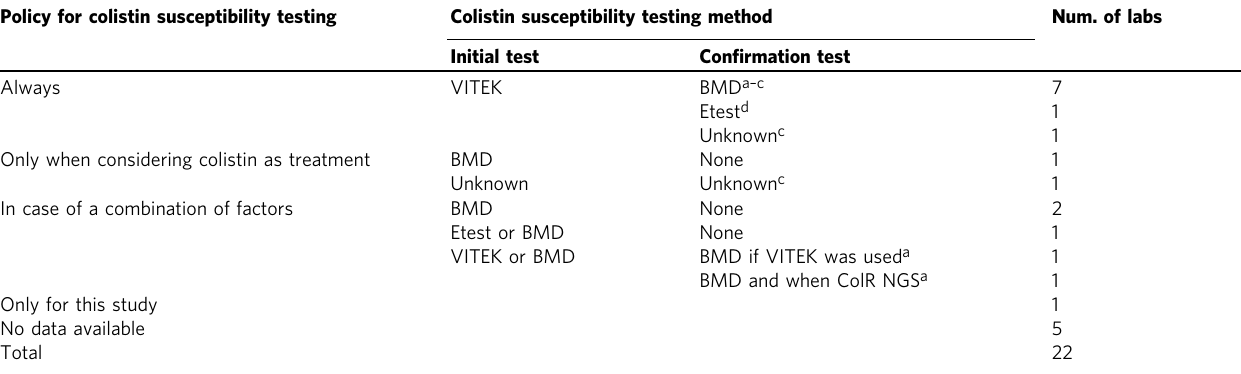
Table 2 Colistin susceptibility testing policies and methods for